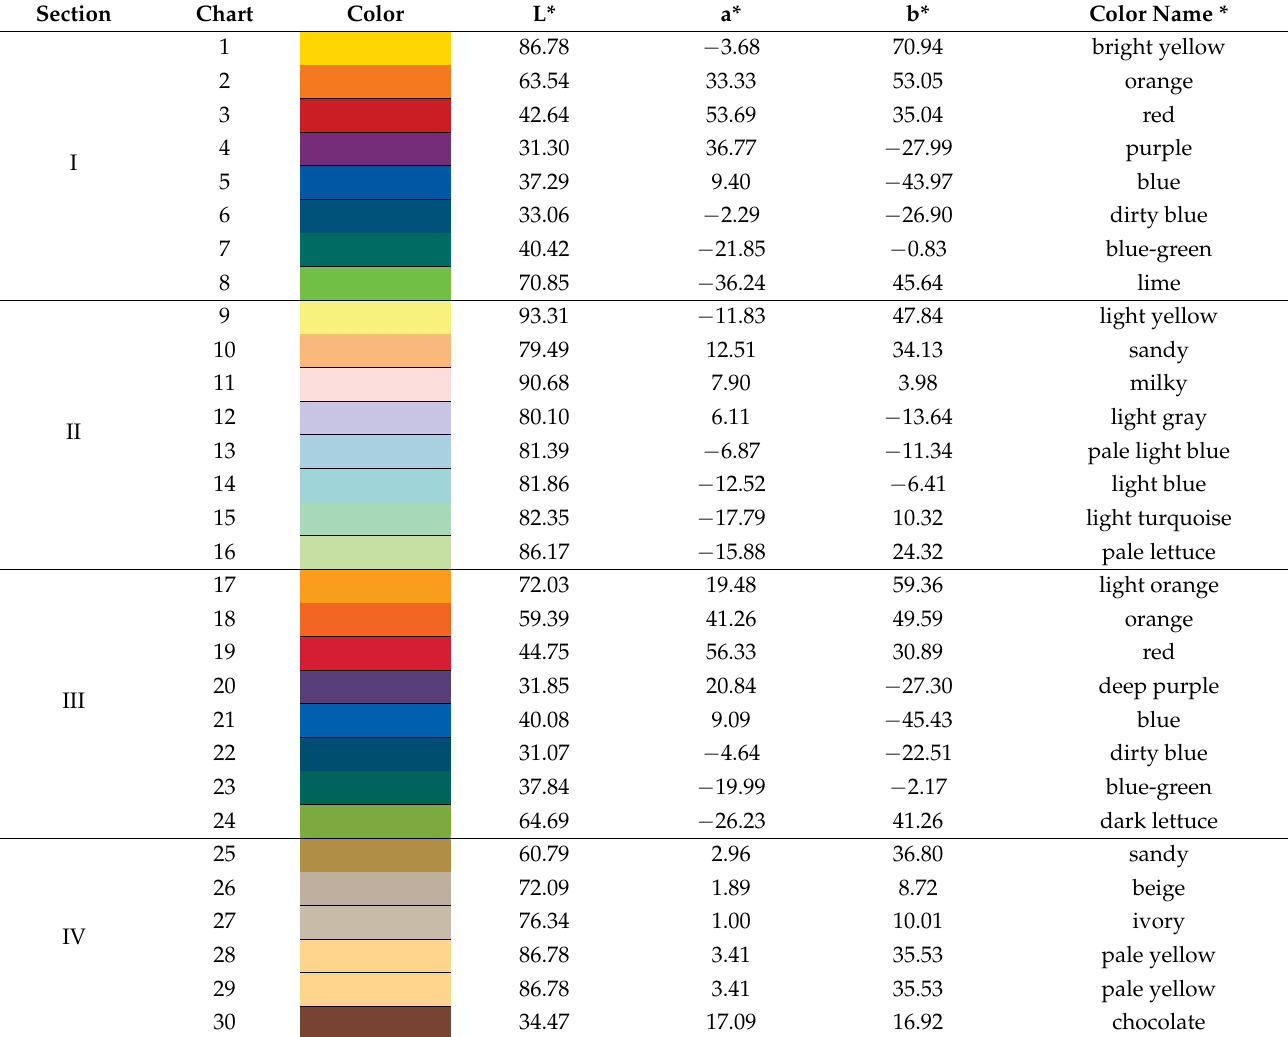
Table 1. Main active